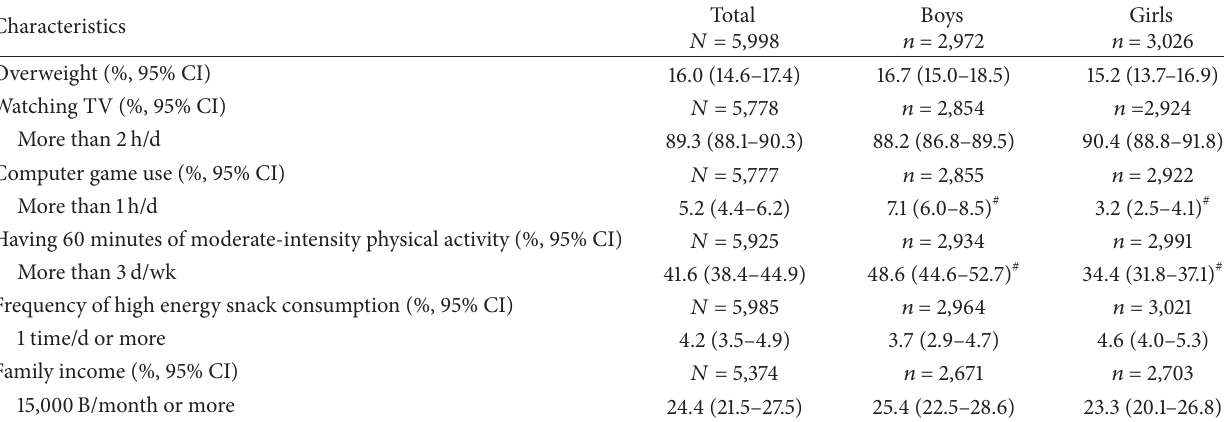
Table 1: Subject characteristics.